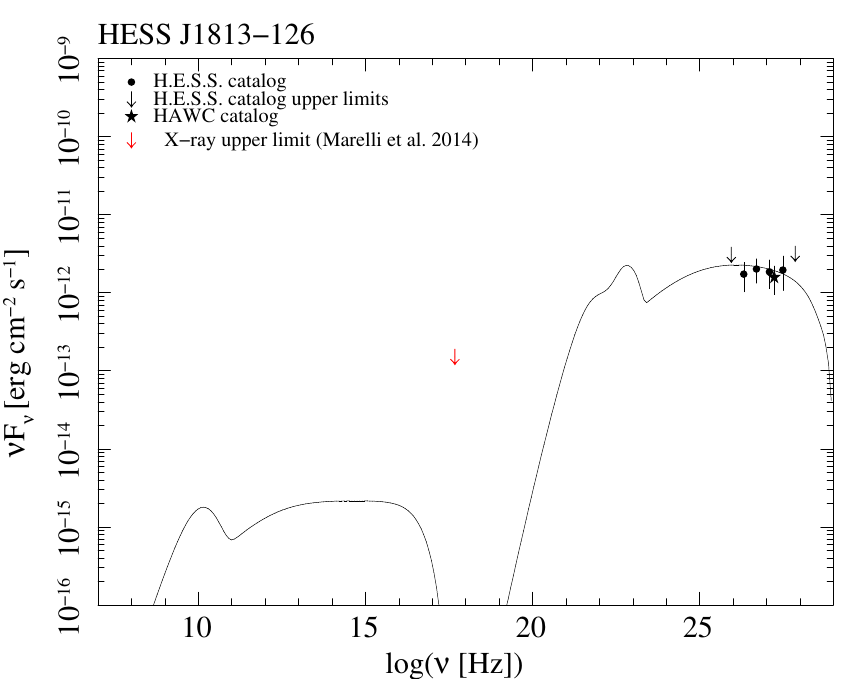
Figure 3. Spectral energy distribution of HESS J1813-126, with the TeV gamma ray spectrum from the H.E.S.S. catalog [76] shown as circles and upper limits and that from the HAWC catalog [80] shown as star. The X-ray upper limit (arrow) is taken from [81], and the results of emission modelling using the time-dependent PWN model described in the text is